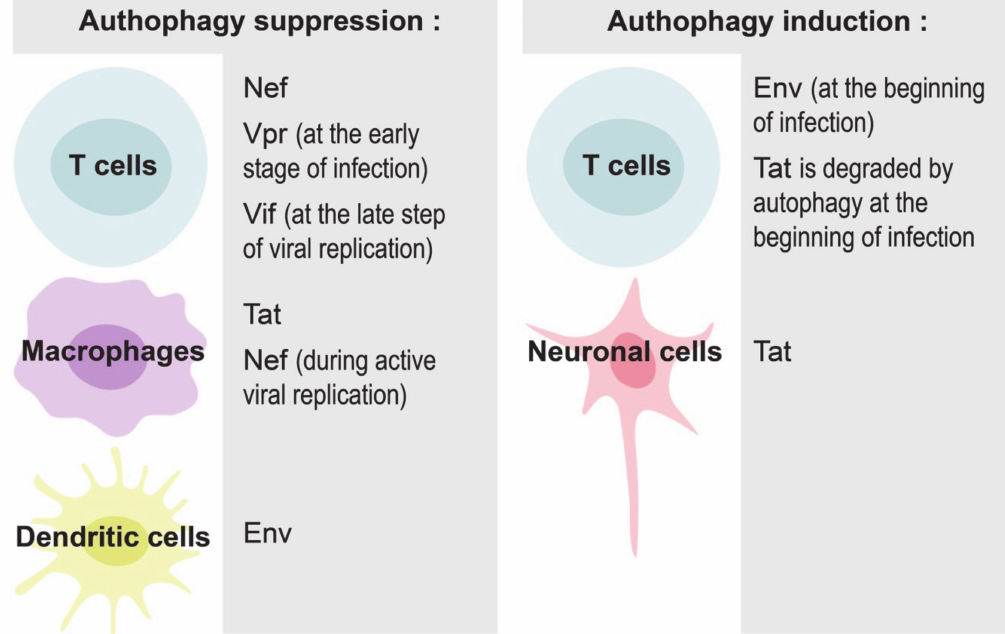
Figure 2. Implication of various HIV-1 proteins in the modulation of autophagy in di ff erent